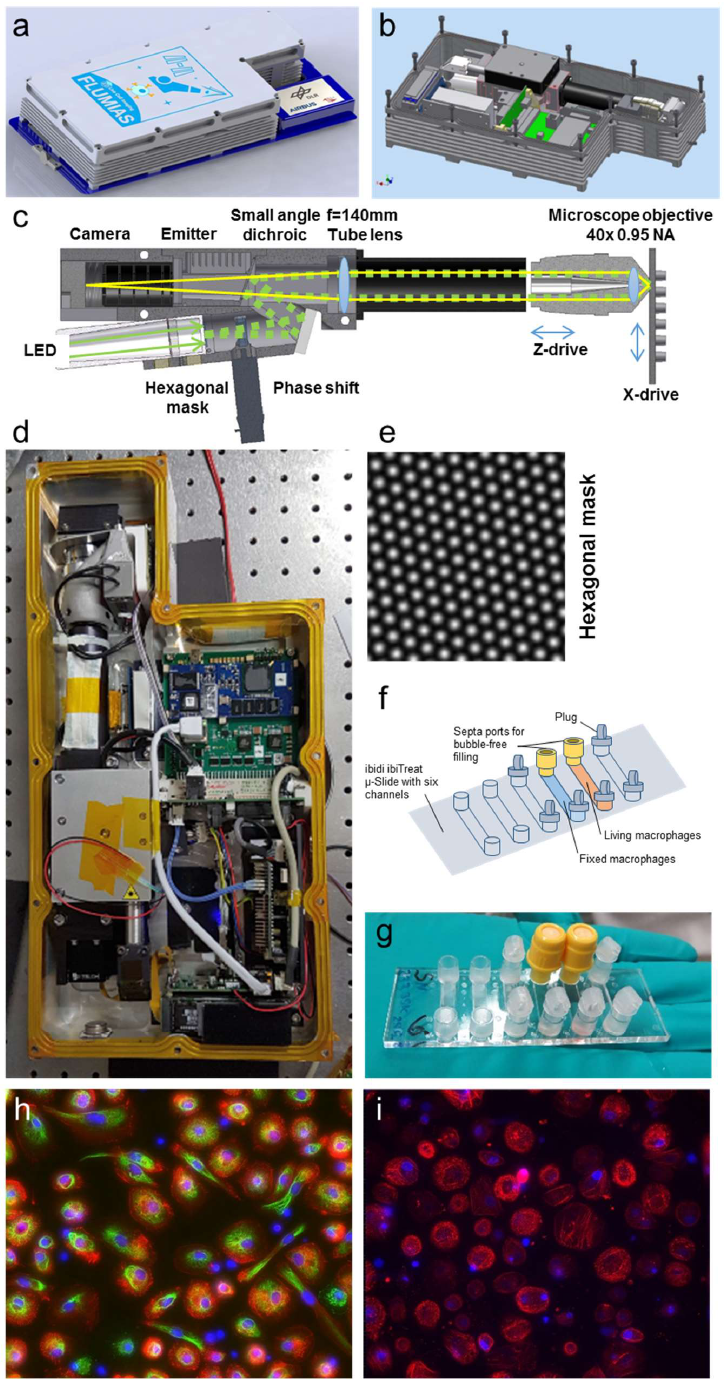
Figure 1. The FLUMIAS-DEA microscope. ( a ) CAD-image of the microscope attached to the Tango Lab carrier card. ( b ) CAD-image with the double sealed cover removed. ( c ) Optical beam path of the microscope. The excitation light coming from the LED is structured by passing the hexagonal mask and moved by the phase shift motor. A quad-band small angle dichroic is reflecting the excitation light towards the sample passing the tube lens and focused by the Nikon 40×, 0.95 NA air corrected objective. The objective is moved by a piezo to acquire z-stacks. The ibiTreat µ-Slide VI 1.9 (custom